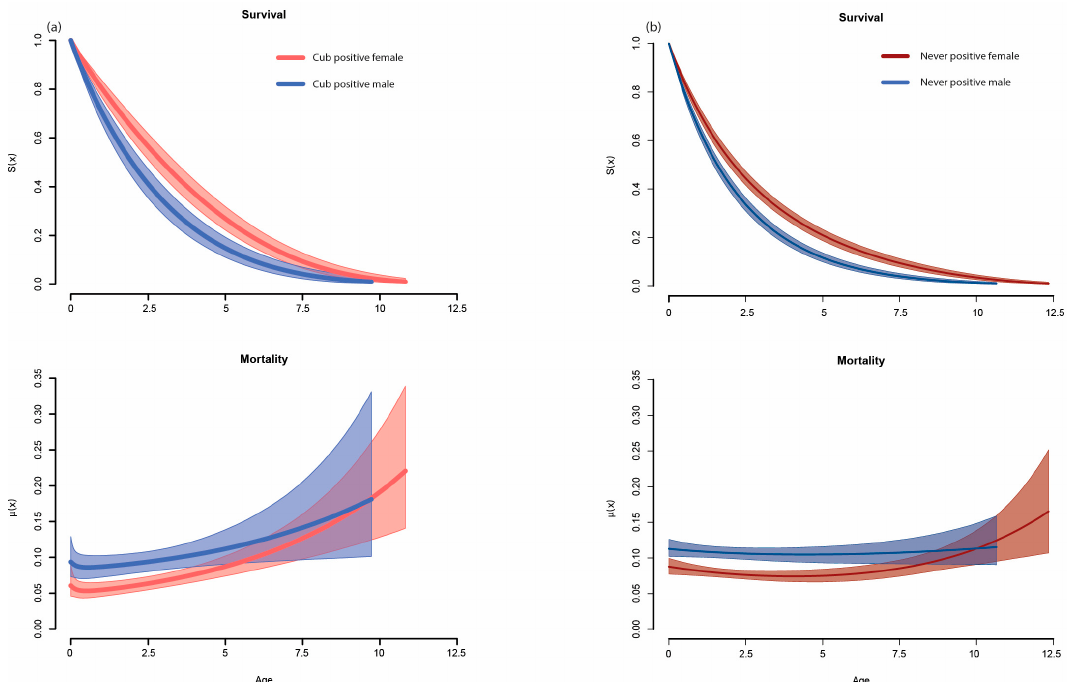
Figure 2. Age-specific survival and mortality trajectories of European badgers from a wild population naturally infected with bovine tuberculosis: ( a ) “cub-positive” individuals (badgers that tested positive in the first year of their lives) and ( b ) “never-infected” individuals (badgers that never tested positive throughout their lives). Female (red) and male (blue) estimated survival and mortality curves of the Siler function. Coloured areas surrounding the curve represent 95% credible intervals. Age in